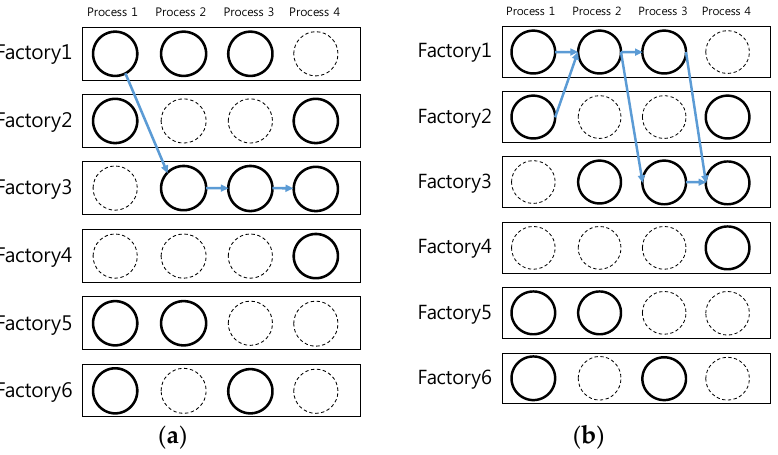
Figure 4. Dynamic supply chain design and operation. ( a ) Individual request; ( b ) Demand for marketing test. Table 6. Production plan–Demand for marketing test. Table 5. Production plan–Individual request.